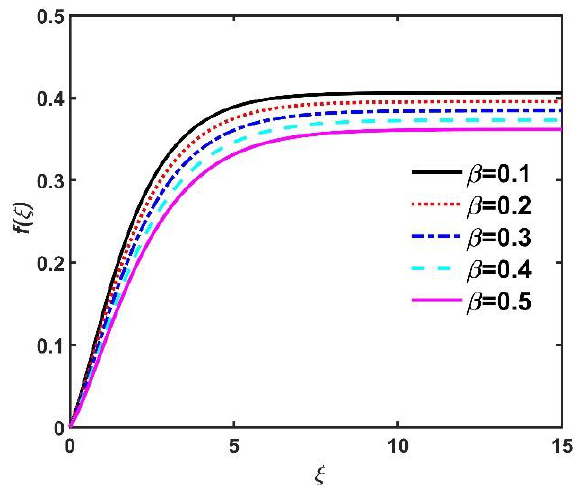
Figure 8. Impact of 𝛽 on 𝑓(𝜉) .